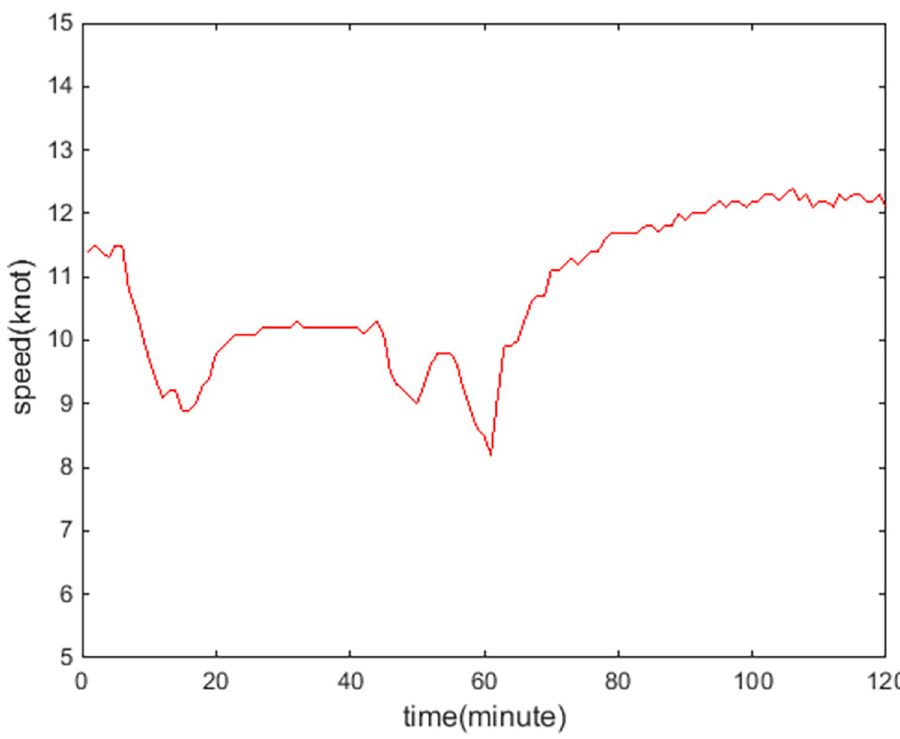
Fig 10. Speed dynamic curve of the own ship.